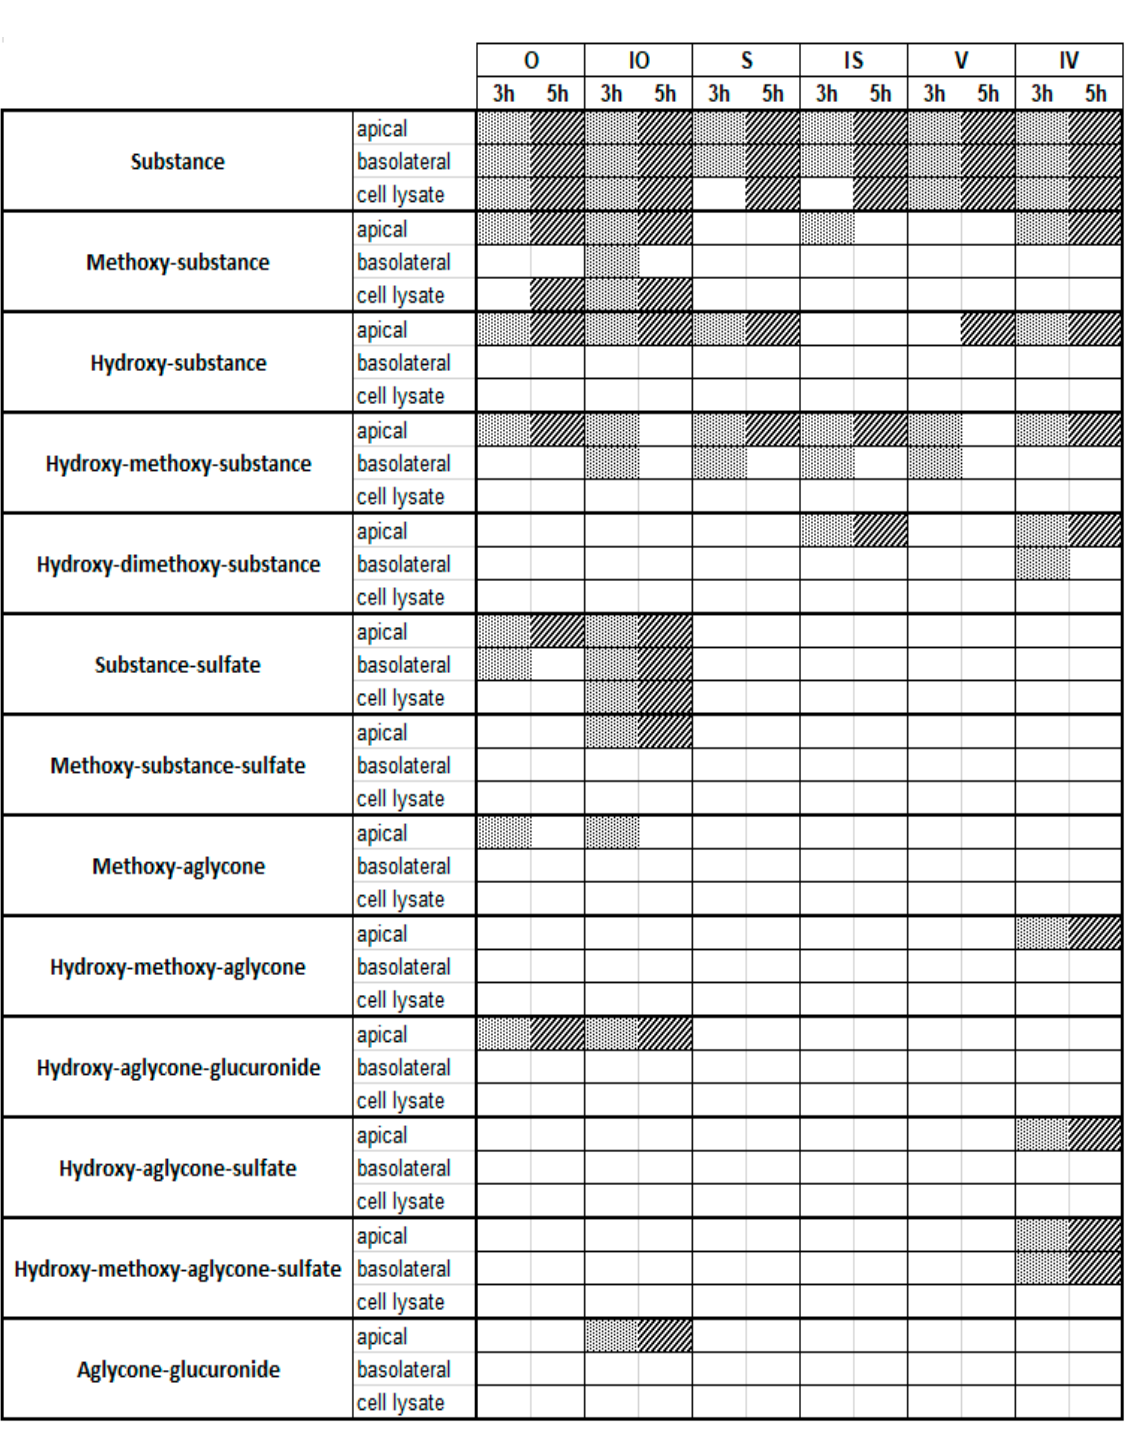
Figure 4. Metabolites detected via UHPLC-MS after a Caco-2 metabolism experiment with 100 µM of the testing substances and incubation times of 3 h and 5 h. Dot line and diagonal line are used for better visualization meaning that the metabolite is detectable.